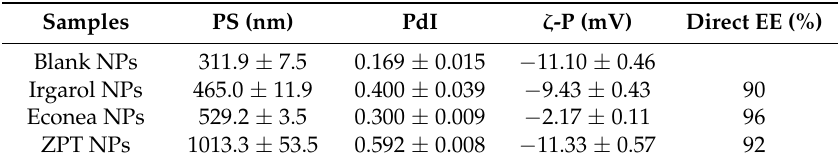
Table 3. Size (PS), size distribution (PdI), zeta potential ( ζ -P) and encapsulation efficiency (EE) values of the prepared PLA